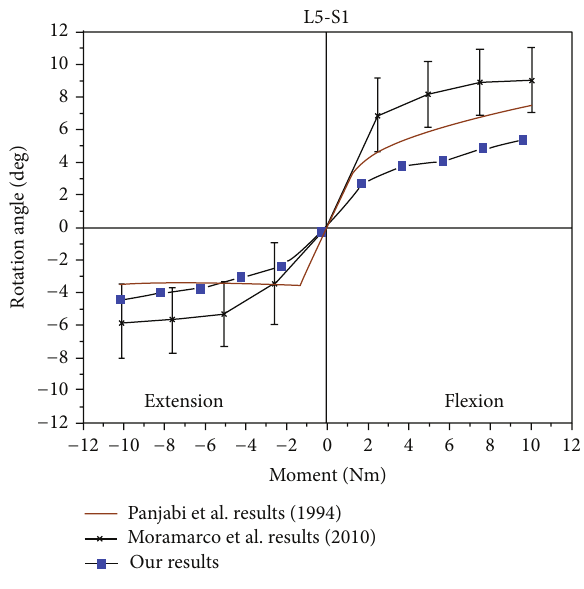
Figure 13: Accurate validation of our spine